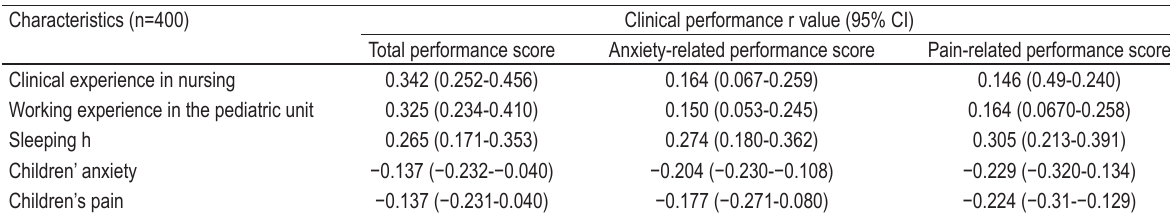
TABLE 4. Correlations of clinical performance score of nurses during venipuncture with general and clinical characteristics Characteristics